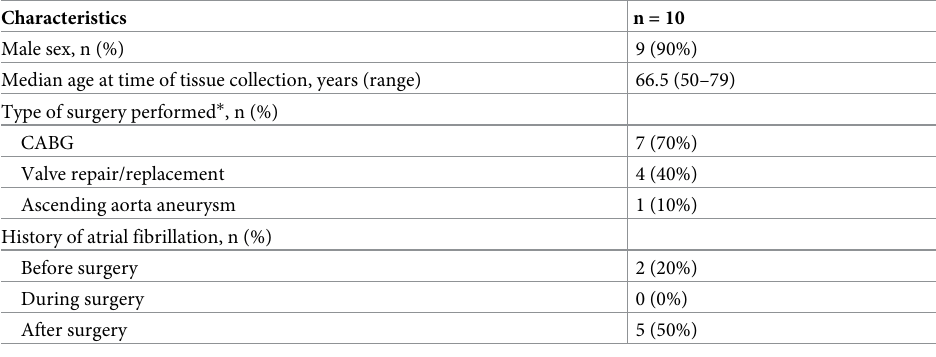
Table 1. Descriptive characteristics of the study population. Characteristics n = 10 Median age at time of tissue collection, years (range) Type of surgery performed * , n (%) CABG Valve repair/replacement Ascending aorta aneurysm 1 (10%) History of atrial fibrillation, n (%) Before surgery 2 (20%) During surgery 0 (0%) After surgery 5 (50%) * Two patients underwent both coronary artery bypass graft (CABG) and valve repair/replacement